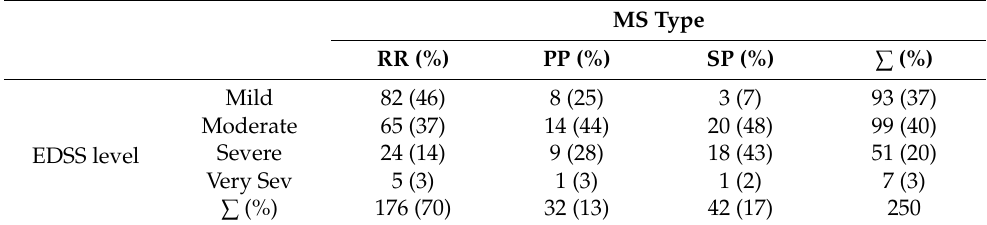
Table 2. Distribution of the sample according to the type of MS and neurological disability level.